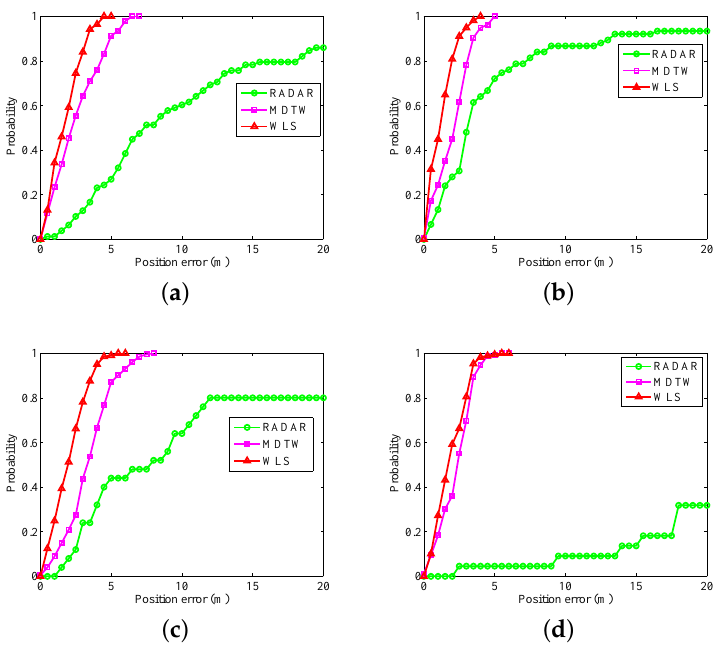
Figure 11. CDF for RADAR, MDTW, WLS: ( a ) calling; ( b ) dangling; ( c ) handheld; and ( d )